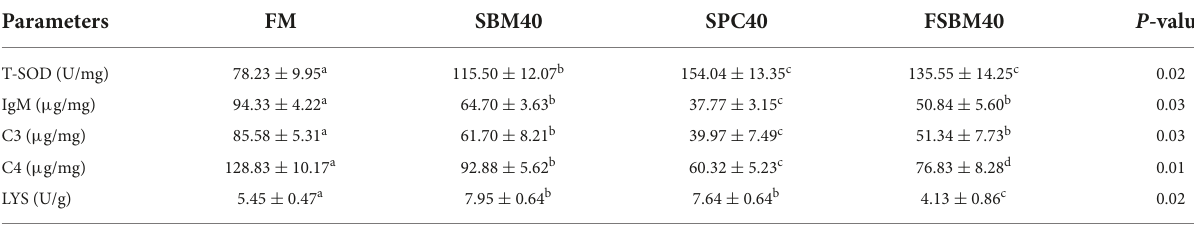
TABLE 6 Effect of different soy meals at 40% substitution levels for fish meal on the enzyme activities of pearl gentian grouper ( n = 3).